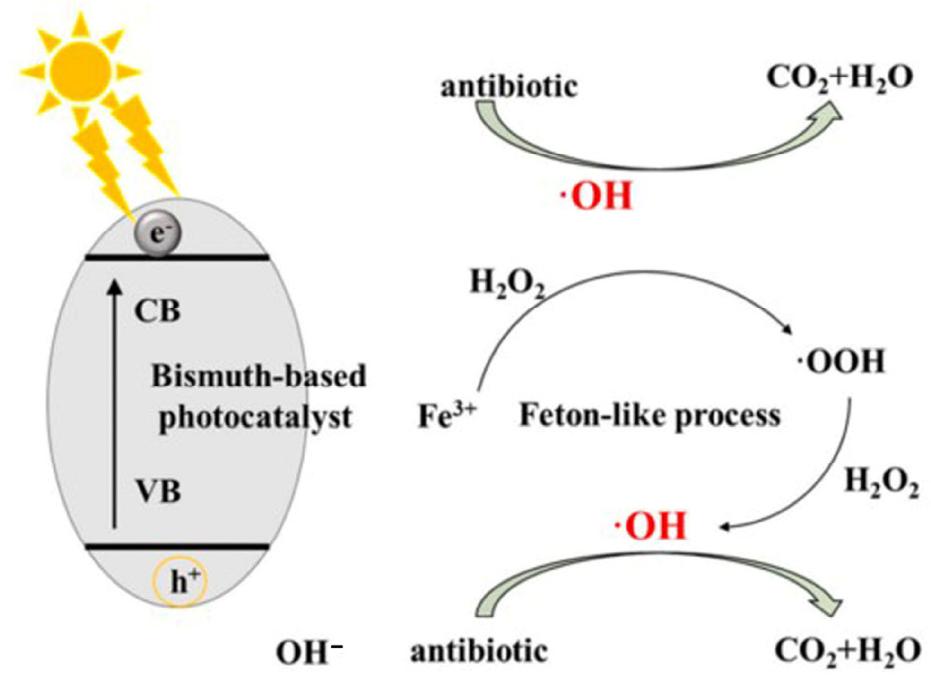
Figure 4. The mechanism of coupled processes with bismuth-based compounds for antibiotic degradation. (Reproduced with permission from [26], copyright 2021, Elsevier).